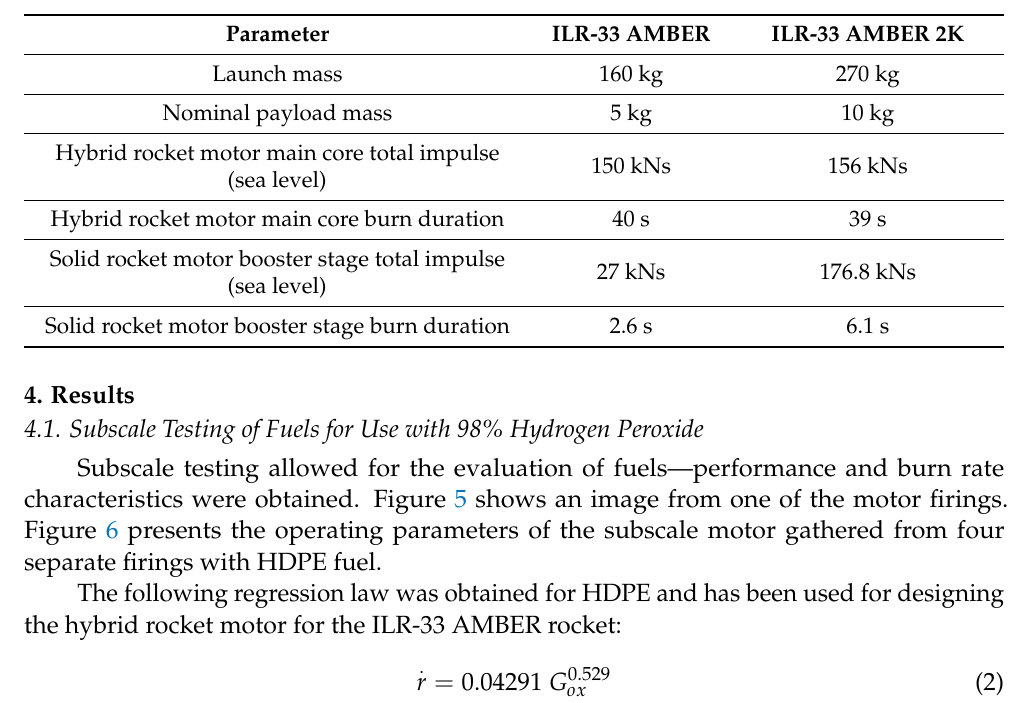
Figure 4. The ILR-33 AMBER in ( a ) its first version and ( b ) the ILR-33 AMBER 2K configuration [109]. Table 3. Key methods—propulsion technology development for the ILR-33 AMBER